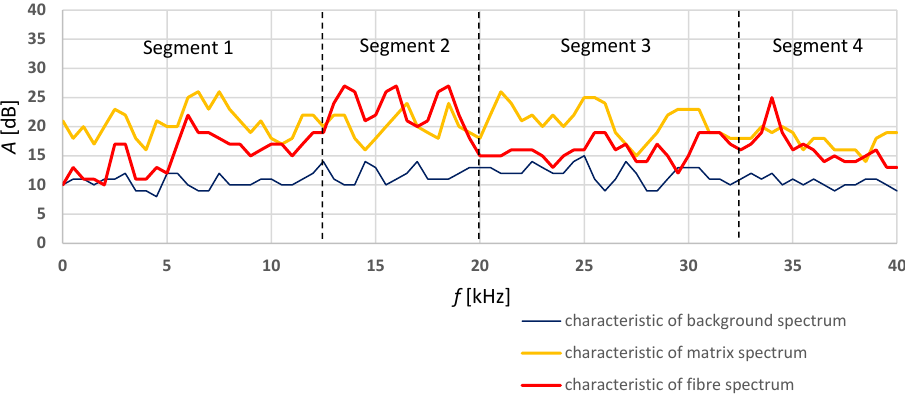
Figure 7. Background, fibre and cement matrix acoustic spectrum characteristics versus frequency.